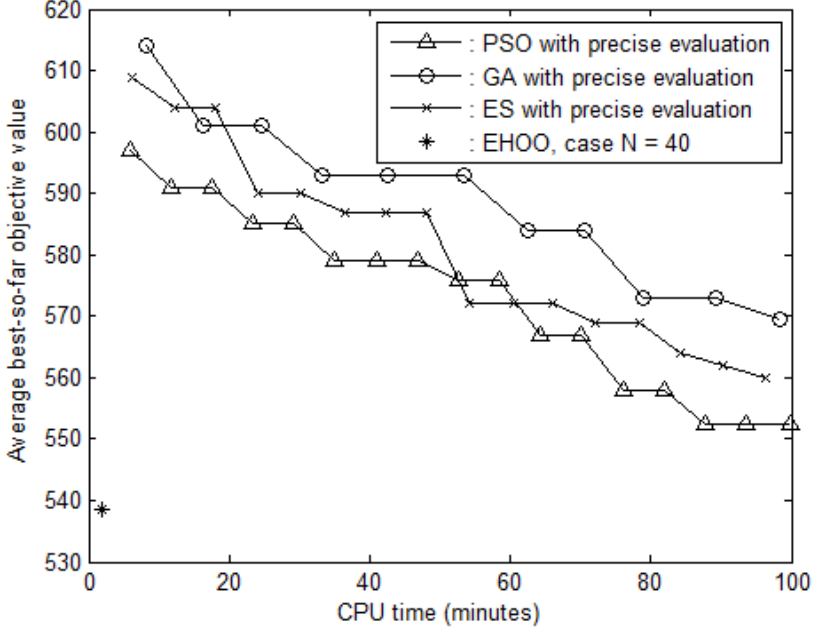
Figure 6. Progressions of four approaches over 30 individual runs. Table 5. Comparison of the average best-so-far objective values of four methods over 30 individual runs. Approaches